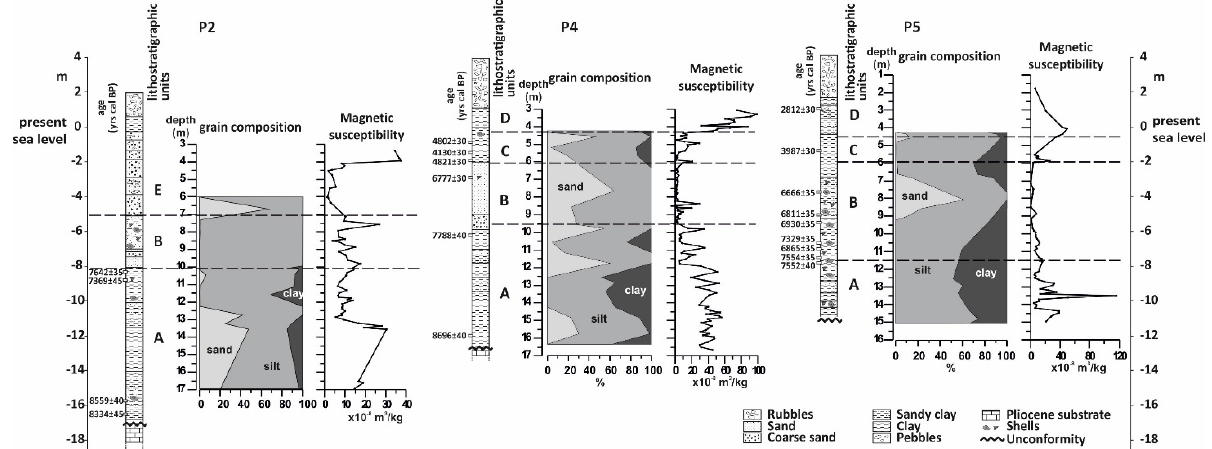
Figure 2. Lithostratigraphic columns of the studied boreholes and the results of the performed sedimentological and magnetic susceptibility analyses. Lithostratigraphic units (A–E, separated by dotted lines) and the chronostratigraphic framework are based on [28].